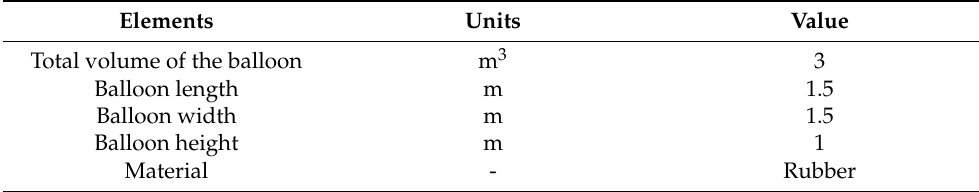
Table 5. Characteristics of the chosen